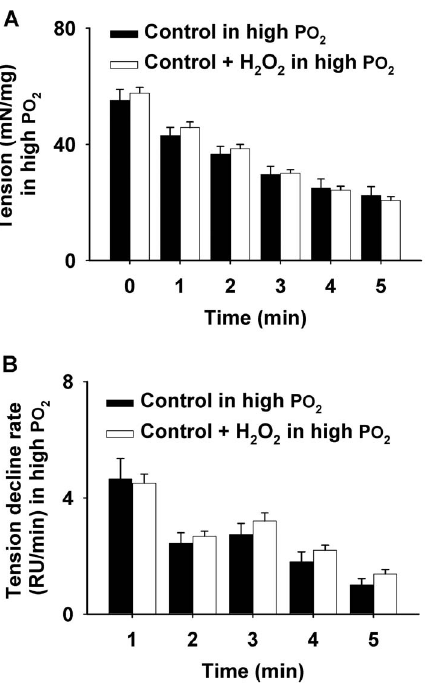
Figure 6. Grouped data showing the effect of H 2 O 2 (50 m M) on the muscle contraction during high PO 2 in a blocked order. A: Tension development (mN/mg) at 1–5 min during the 5-min contrac- tion period in the presence vs. absence of H 2 O 2 . B: Tension decline rate (RU/min) during the 5- min contraction period at 1–5 min in the presence vs. absence of H 2 O 2 .